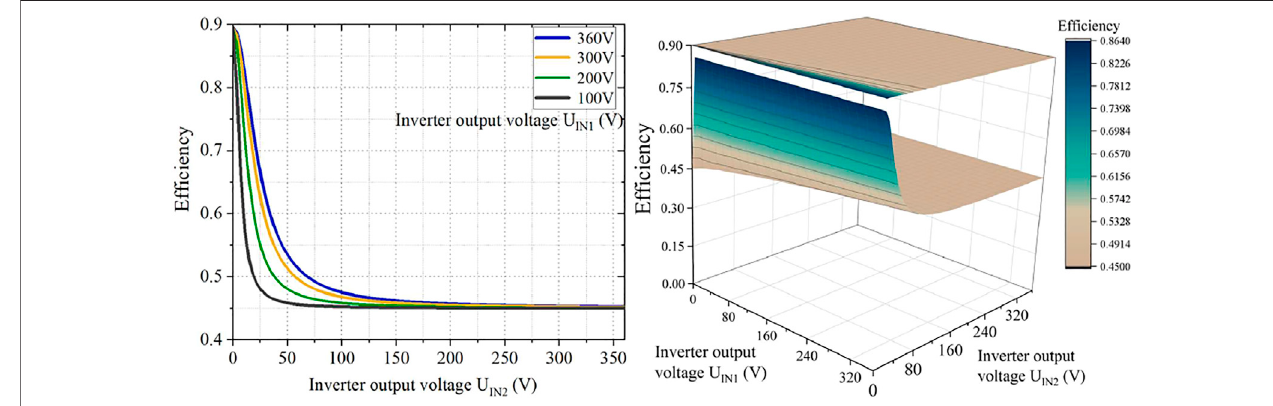
FIGURE 7 | Variation of the ef fi ciency versus inverter output voltage.